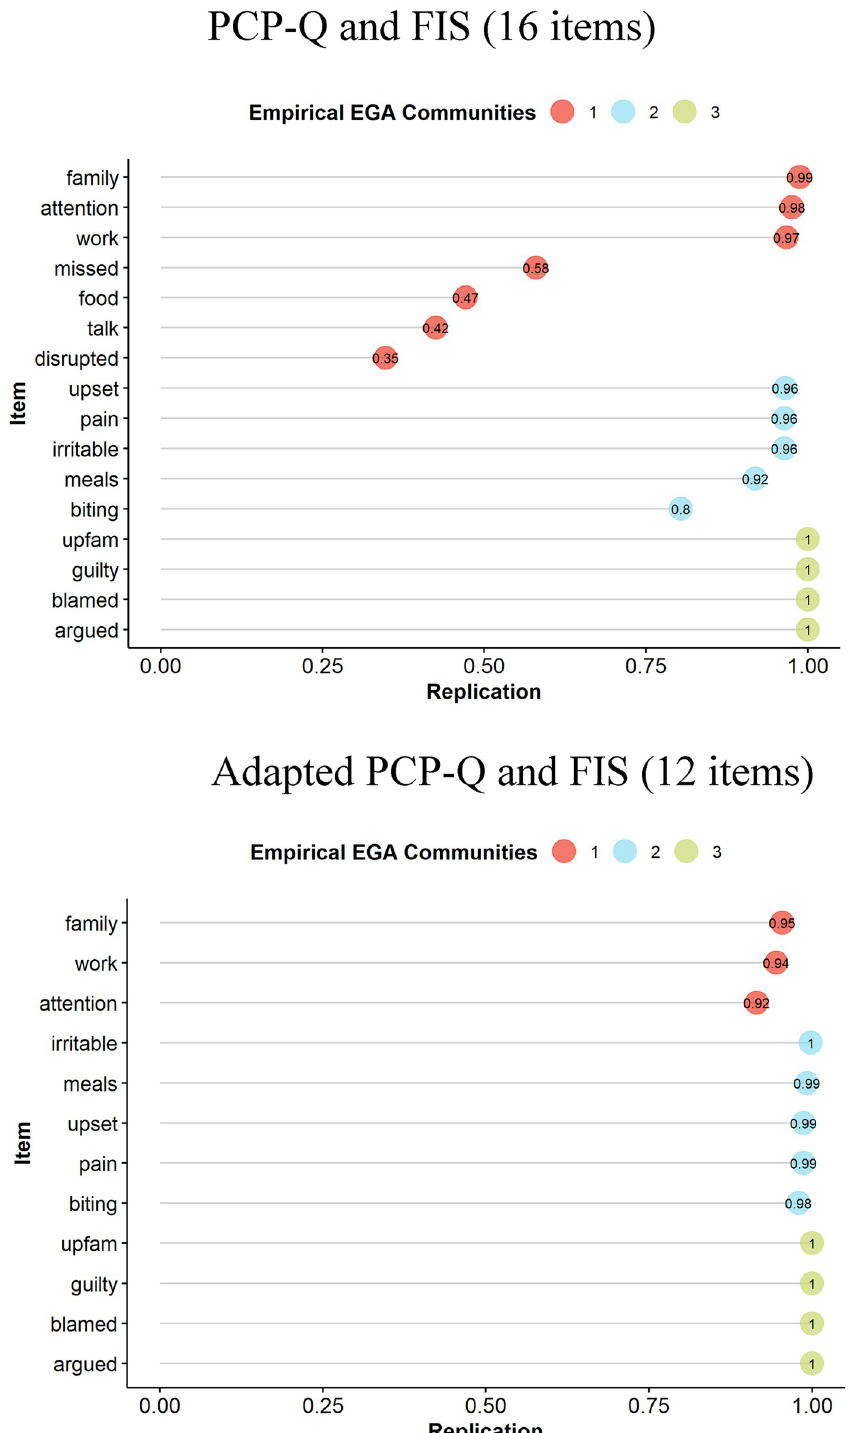
Fig 3. Item stability of the P-CPQ and FIS items. Note. The y-axis indicates the items. The circles are coloured according to their EGA-identified dimension. The x-axis indicates the proportion of times the item clustered with the EGA-identified dimension across the bootstrap samples. The number inside the circle indicates the proportion of times the item clustered with the EGA-identified dimension for each individual item.